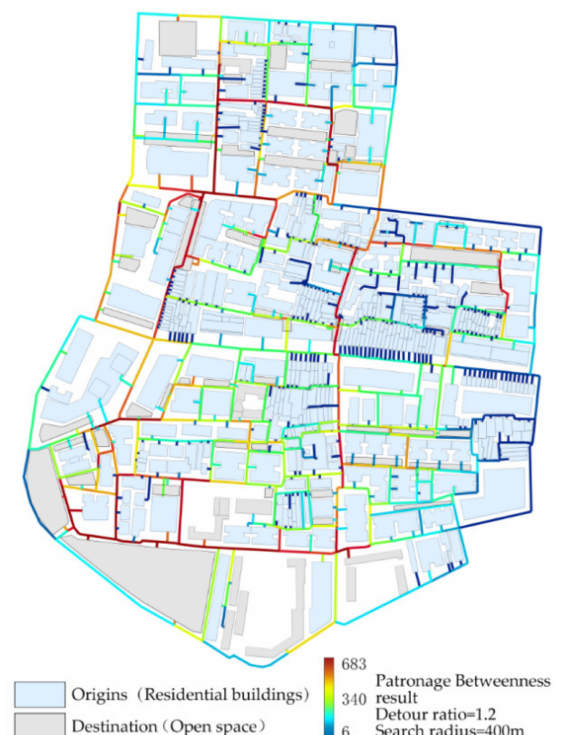
Figure 7. Simulation results of pedestrian flow distribution from residential buildings to public activity